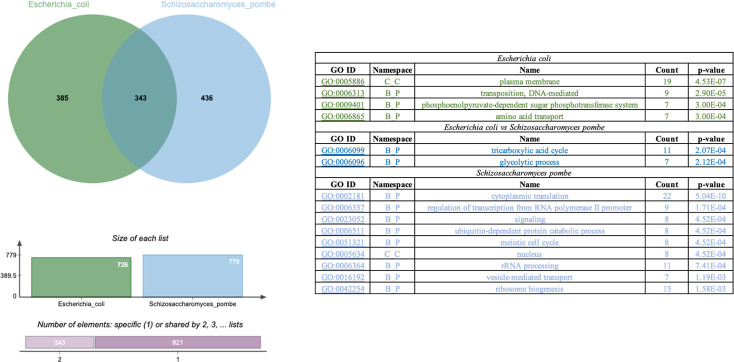
Analysis of ortholog and co_orthologs present in Escherichia coli and Schizosaccharomyces pombe.Venn diagram showing the distribution of shared orthologous clusters among Escherichia coli and Schizosaccharomyces pombe. Clusters of orthologs genes show that E. coli shares 343 clusters of orthologs genes with S. pombe, possessing 385 clusters that are only present in the bacteria and 436 in the fission yeast. Table shows the cluster of orthologs enriched in E. coli, S. pombe and in both organisms.